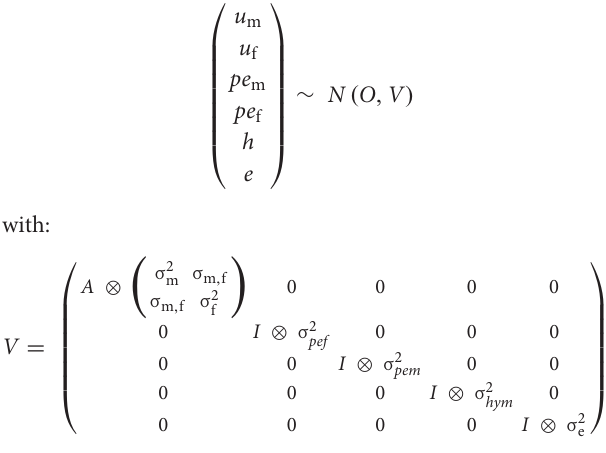
TABLE 1 | Descriptive statistics for the phenotype of reproductive traits in Holstein cattle. Trait